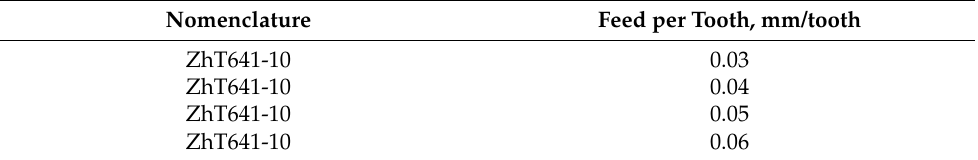
Table 5. The feed rates under study.